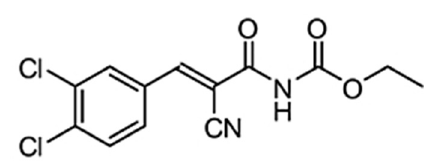
Figure 1. Structure of FSC231.